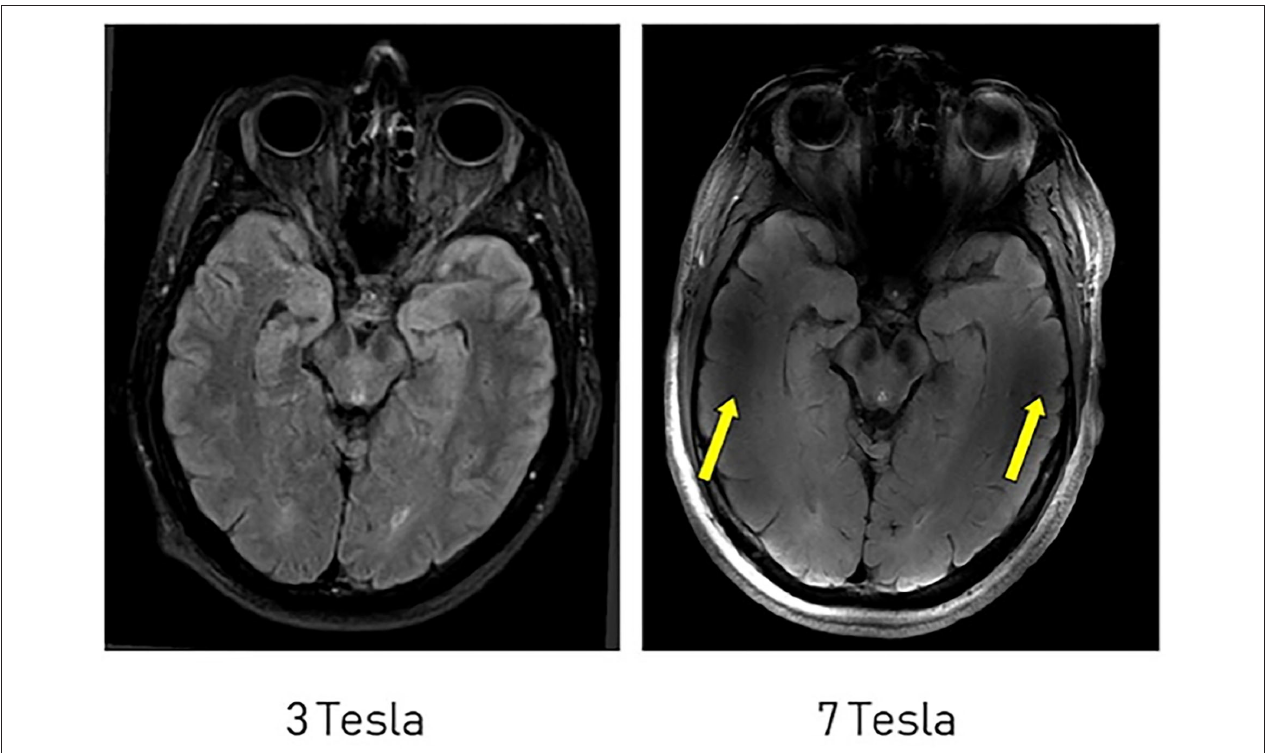
FIGURE 3 | Comparison of FLAIR imaging at 3T and 7T. Artifacts are more significant near the skull base at 7T (yellow arrows). This figure is used with permission from Regnery et al. (